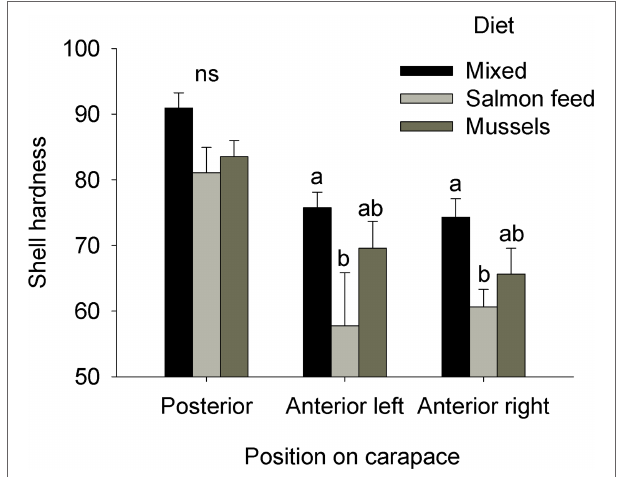
FIGURE 5 | Impact of experimental diets on gonadal and hepatopancreatic indices in the rock crab Cancer irroratus . Replicates are the mean values for each experimental tank. Log-transformed gonad index was analyzed, but raw data is presented. Bars show mean +SE and columns not sharing a common letter are significantly different (Tukey HSD post-hoc tests, n = 5-9). The total number of individuals included in the analyses was 23, 11, and 13 for the mixed, salmonid feed and mussel diets, respectively.